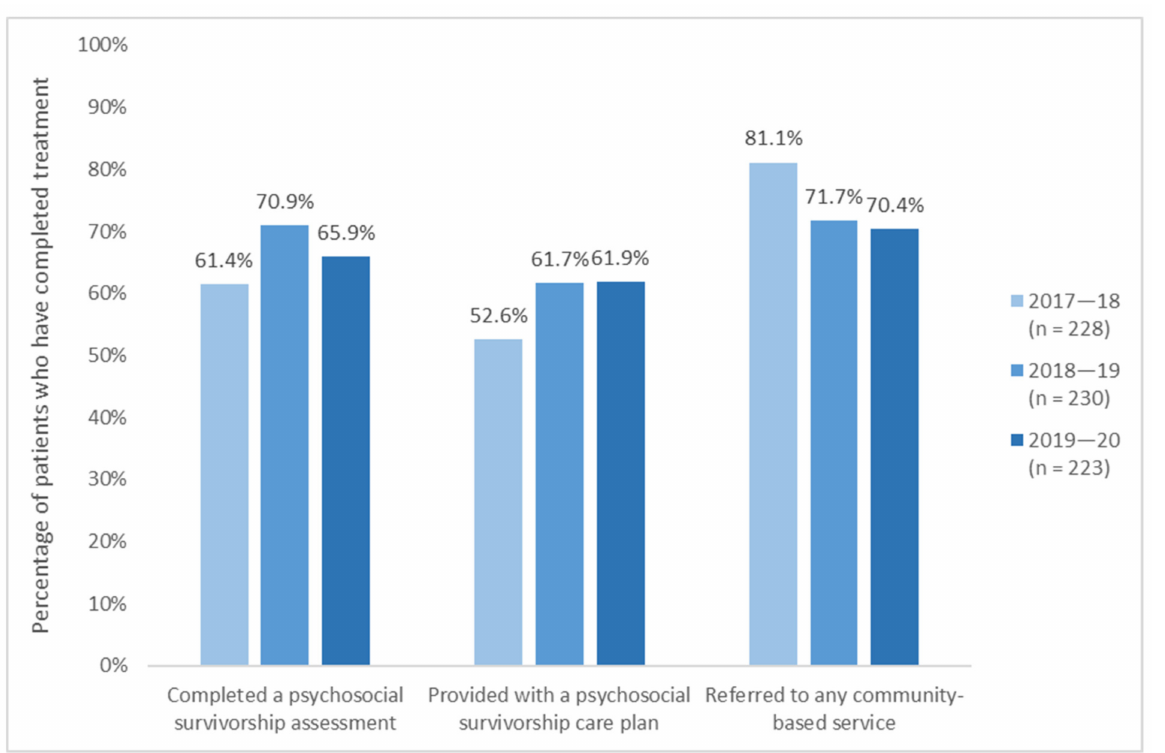
Figure 4. YCS activity data on survivorship care, 2016–17 to